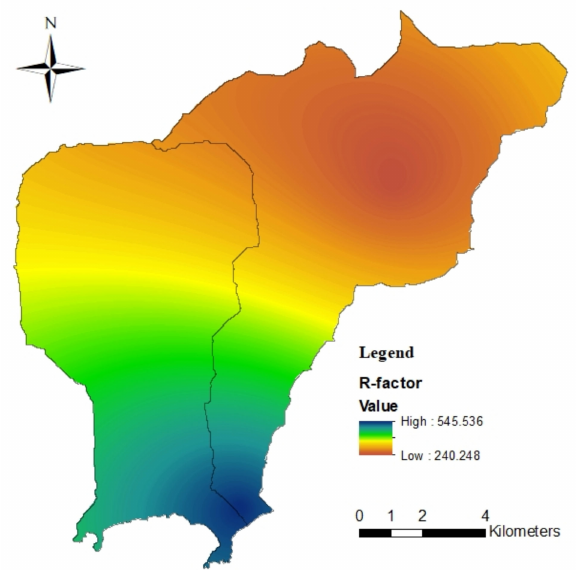
Figure 6. R-factor map derived from rain gauge data.